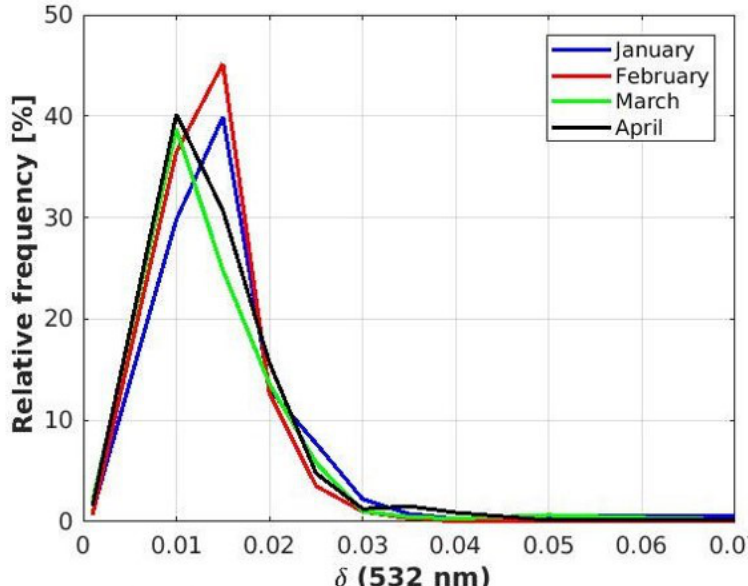
Figure 3. 700–1500 m: Frequency of δ 532